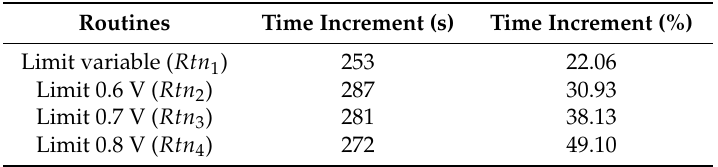
Table 3. Reading and calculated time increment in all configuration routines.